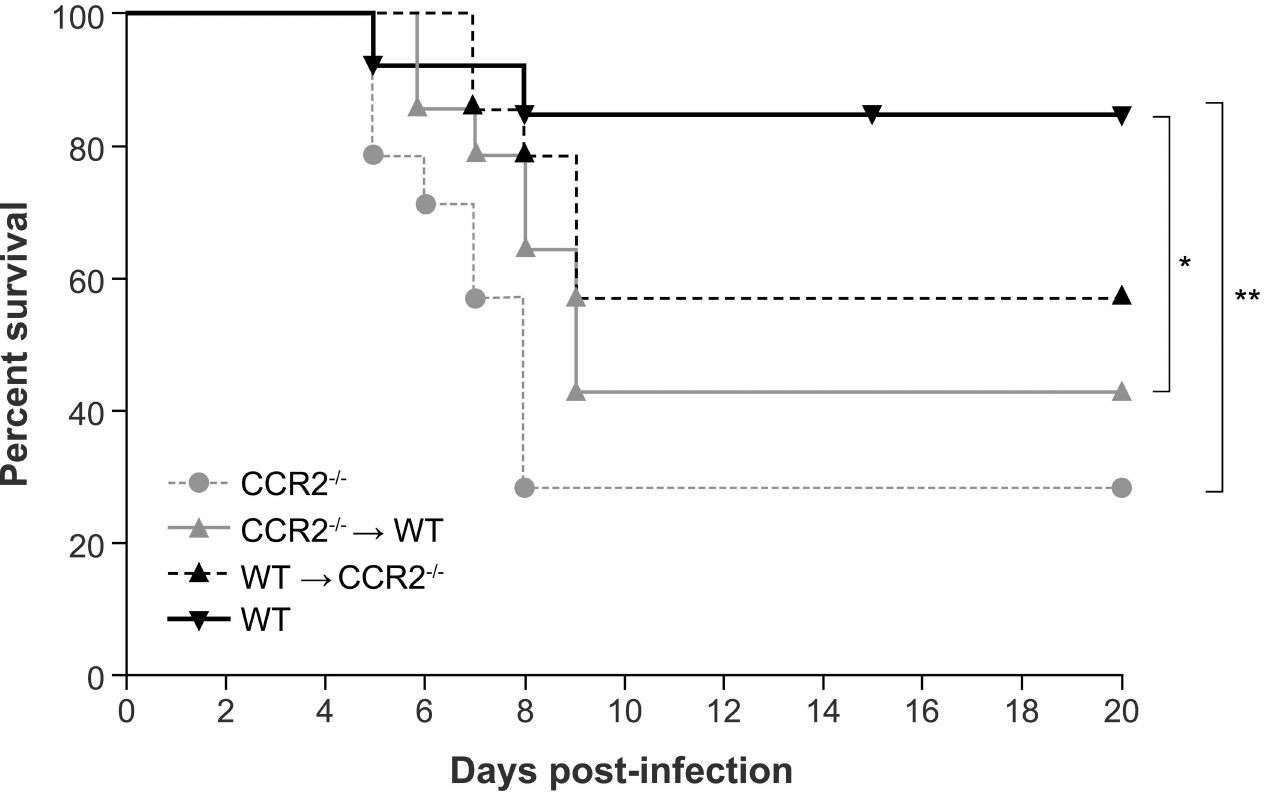
Fig 1. Effect of CCR2 deficiency in resident cells of the CNS or in the hematopoietic systemon mouse survival rates during HSE. Eight- week old recipientwild-type(WT) C57BL/6and CCR2 -/- mice conditionedwith irradiationwere transplanted with bone marrow cells harvestedfrom CCR2 -/- (CCR2 -/- ! WT) and WT (WT ! CCR2 -/- ) animals, respectively.Total body CCR2 -/- and WT mice were used as controls. Sixteen-week old WT, CCR2 -/- , CCR2 -/- ! WT and WT ! CCR2 -/- mice (n = 14 mice per group) were infected intranasallywith HSV-1 (1.2x10 6 plaqueforming units (PFU) in 20 μ l minimalessentialmedium). Mice were examinedcarefully twice a day for 20 days, and two obvioussigns of sickness or a (cid:21) 20% weight loss were considered as endpointsfor sacrifice. Survival curves were analysedusing a log-rank(Mantel-Cox) test. Statistically significant results betweengroups are indicatedas follows: * , P < 0.05; ** , P < 0.01.